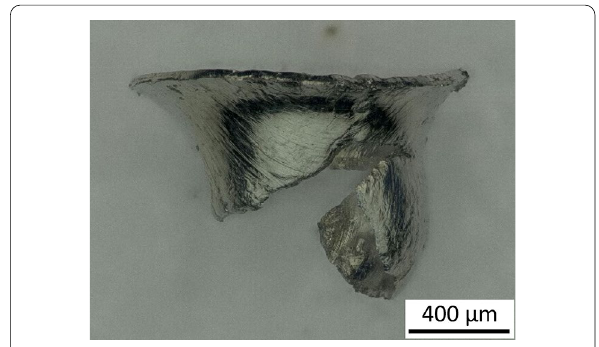
Figure 7 Side view of fractured cup after MDD with the as-received ASS 304 foil